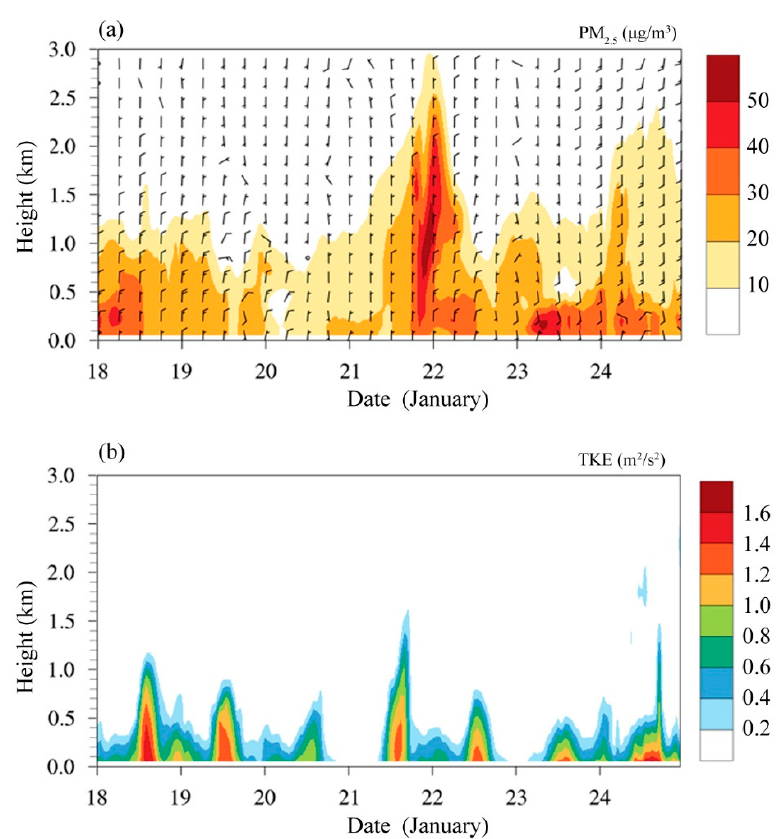
Figure 12. Time series of the ( a ) extra-regional transport of PM 2.5 (shaded; unit: µ g / m 3 ) and simulated horizontal wind field (black wind barbs); ( b ) TKE (shaded; unit: m 2 / s 2 ) in SZ from 18 to 24 January.